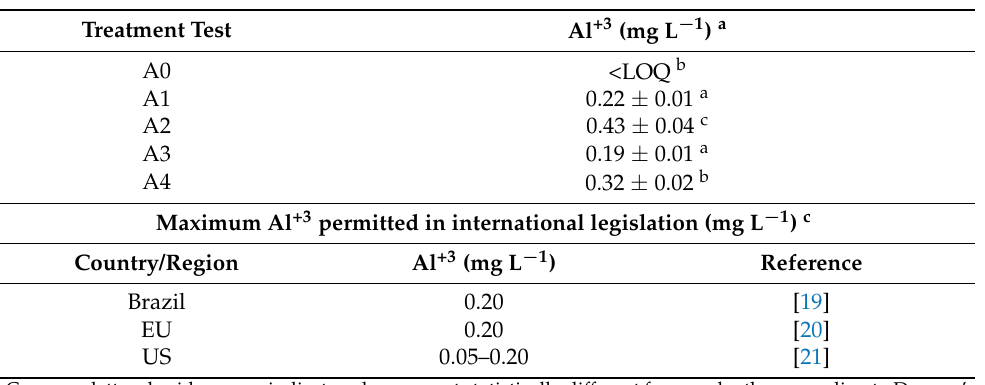
Table 2. Mean ( ± standard deviation; n = 3) residual aluminum (Al +3 ) content in wastewater contami- nated with the herbicide chlorimuron-ethyl (at 1 mg L − 1 ) and untreated (A0) or treated by electroflotation (A1 to A4; see Table 1 for specification of treatment conditions) and comparison with important interna- tional environmental legislation in Brazil, the European Union (EU), and the United States (US).